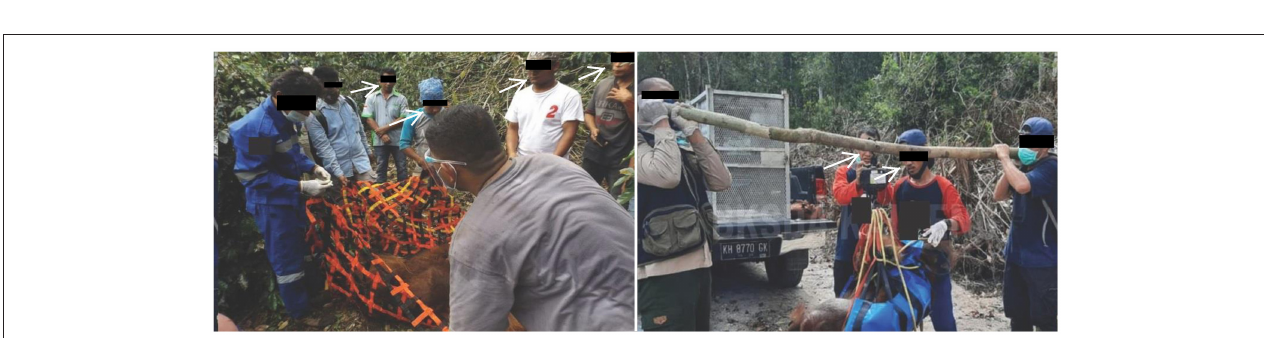
FIGURE 1 | Orangutan translocations in Indonesia since 2015. Annual rates are estimated from Sherman, Ancrenaz and Meijaard (4), available rescue center annual reports and news blogs, KSDAE news blog and unpublished data. Release rates shown may be lower than actual releases, as some rescue centers did not have publicly available data for all years.